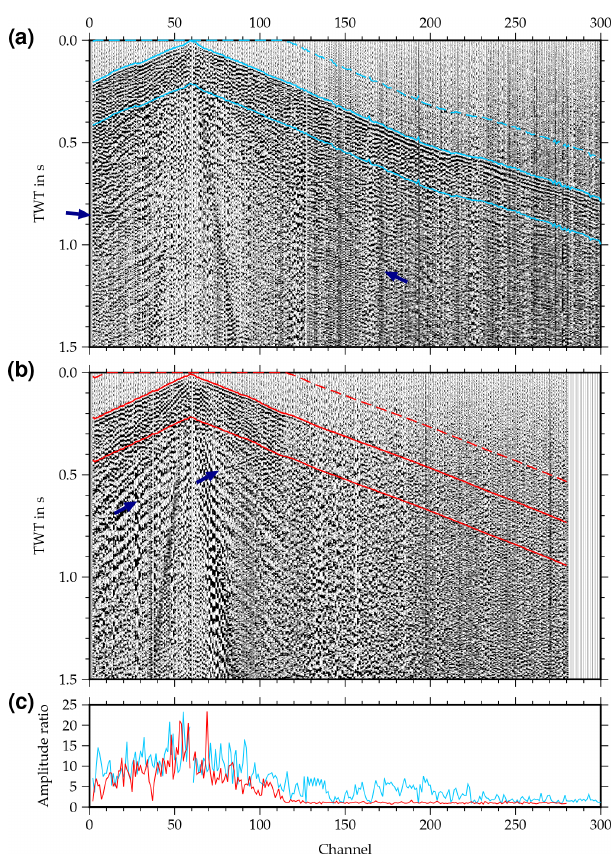
Figure 11. Unprocessed shot gathers illustrating variations in the background noise level. The upper shot gather (a) displays very clear first arrivals along the whole spread, whereas the lower shot gather (b) is dominated by noise for larger offsets. The light blue and red lines mark the windows used for estimating the amplitude ratio between background noise and first arrival (c) . The dark blue arrows indicate reflections.